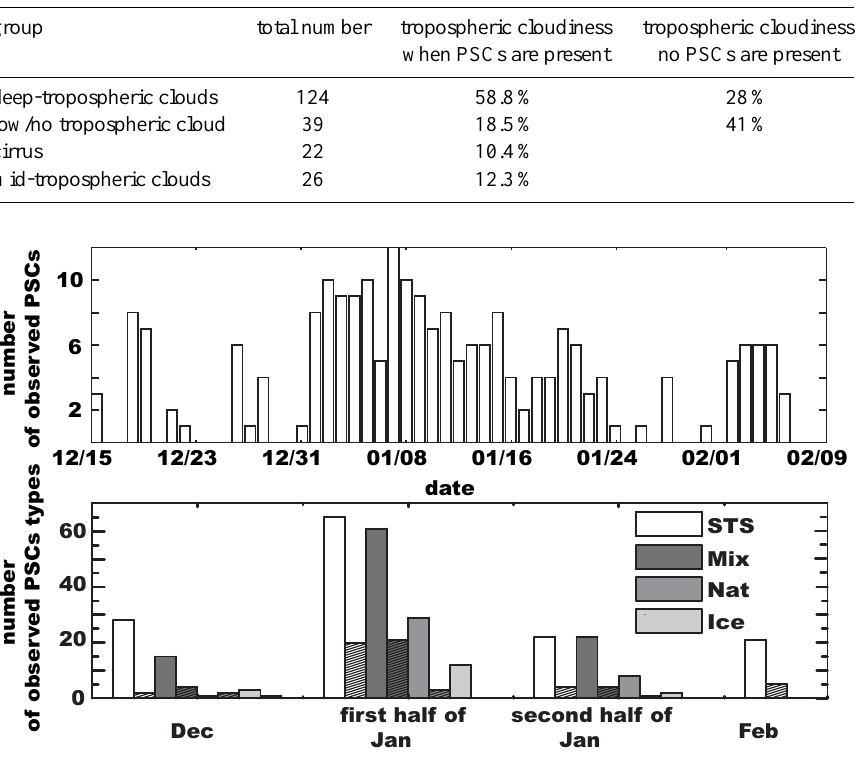
Fig. 3. (a) Daily resolved number of PSCs detected in CALIPSO measurements north of 60 ◦ N during winter 2007/2008. PSCs with a large spatial extent might be counted multiple times as they show up on subsequent CALIPSO tracks. CALIPSO passes the arctic every 100 min with about 25 ◦ longitude shift between. (b) Analysis of the PSC observations in accordance to their type. Unshaded and shaded bars refer to observations over tropospheric clouds or during the absence of tropospheric clouds, respectively. The distribution differs from the display in (a) because individual PSCs might contain areas of different